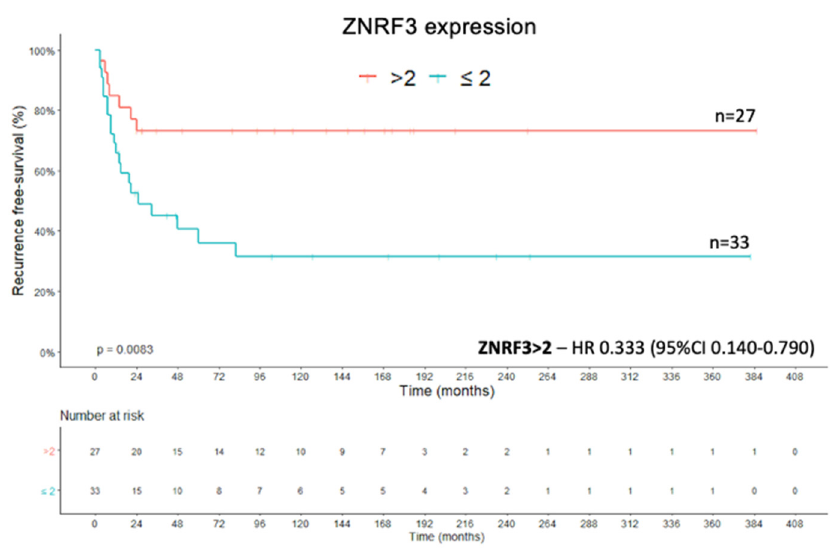
Figure 8. ZNRF3 expression—Recurrence-free survival Kaplan–Meier curve.